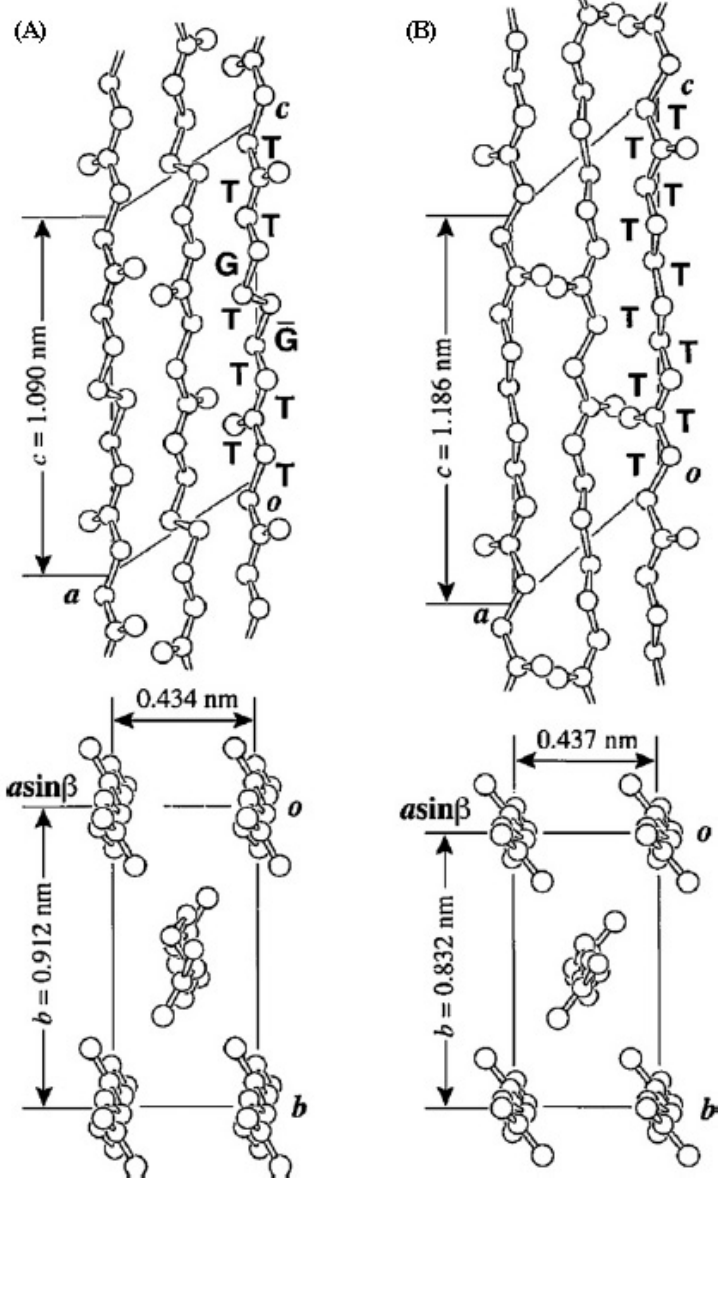
Figure 4. Crystal structures for the α -form ( A ) and the β -form ( B ) of PBS on the a-b (bottom) and b-c (top) base planes. All hydrogen atoms are omitted. Reproduced